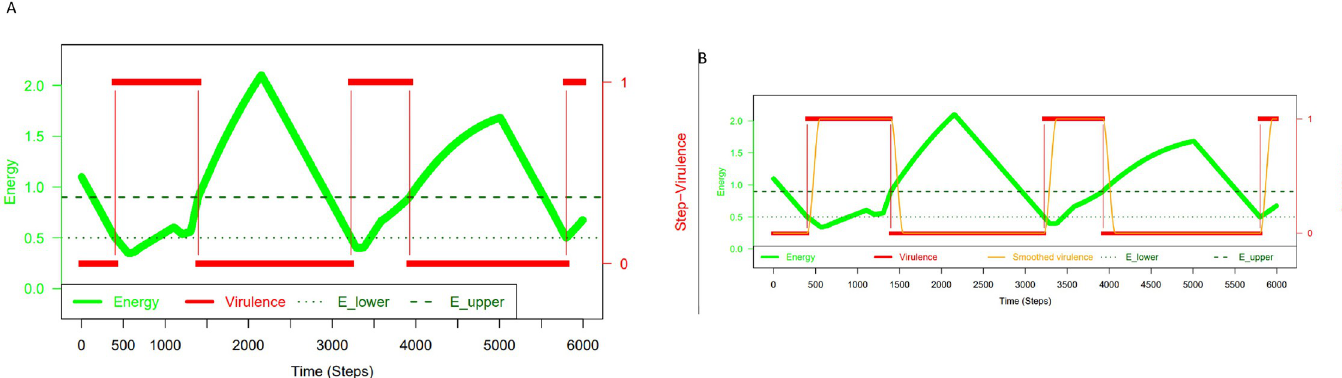
Fig 1. Host-parasite energy-virulence model. (A) Illustrates the relationship between the energy level E = E 1 of the host (in light green) and virulence of its parasites (red and E = E , with two levels, E lower and E upper , through which energy regulates the virulence of parasites that are sensitive to line). Overall there are two energy types, E = E 1 2 them. For simplicity, only one energy E is shown ( E lower dotted line in dark green, E upper dashed line in dark green). Whenever E reaches its lower level virulence becomes maximal, and whenever E attains its upper level virulence will be minimal. (A) Virulence is modelled as a step-function. (B) Virulence is modelled as a smooth-step